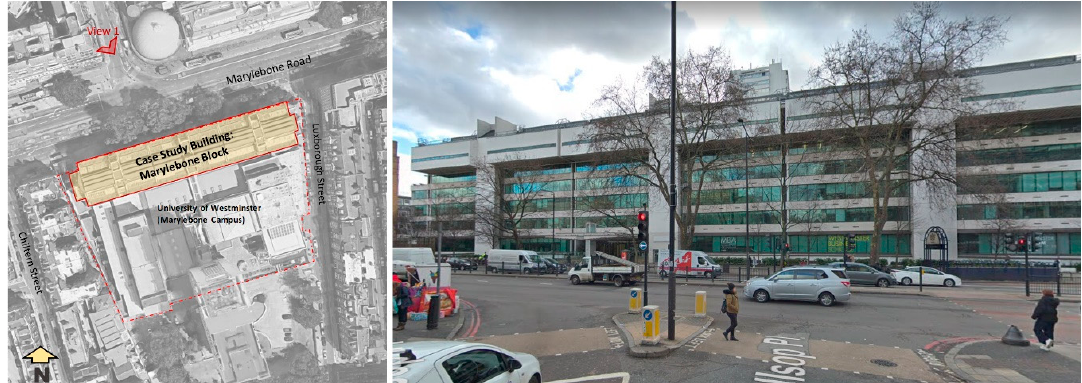
Figure 2. Location of the case study building (source: google maps, edited by author).